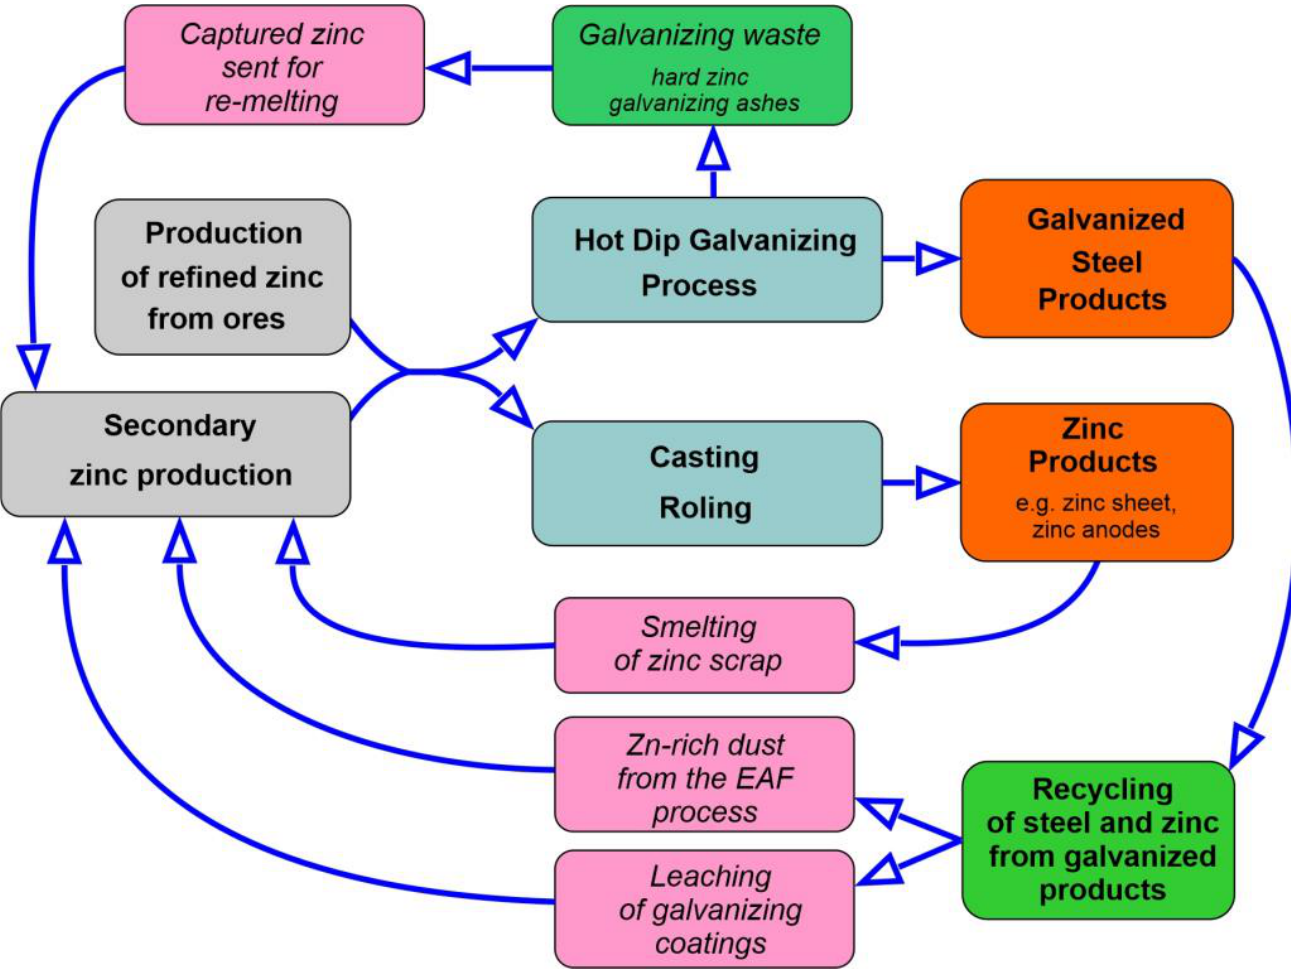
Figure 9. Recycling zinc flow, including the hot dip galvanizing process and finished products withdrawn from circulation.